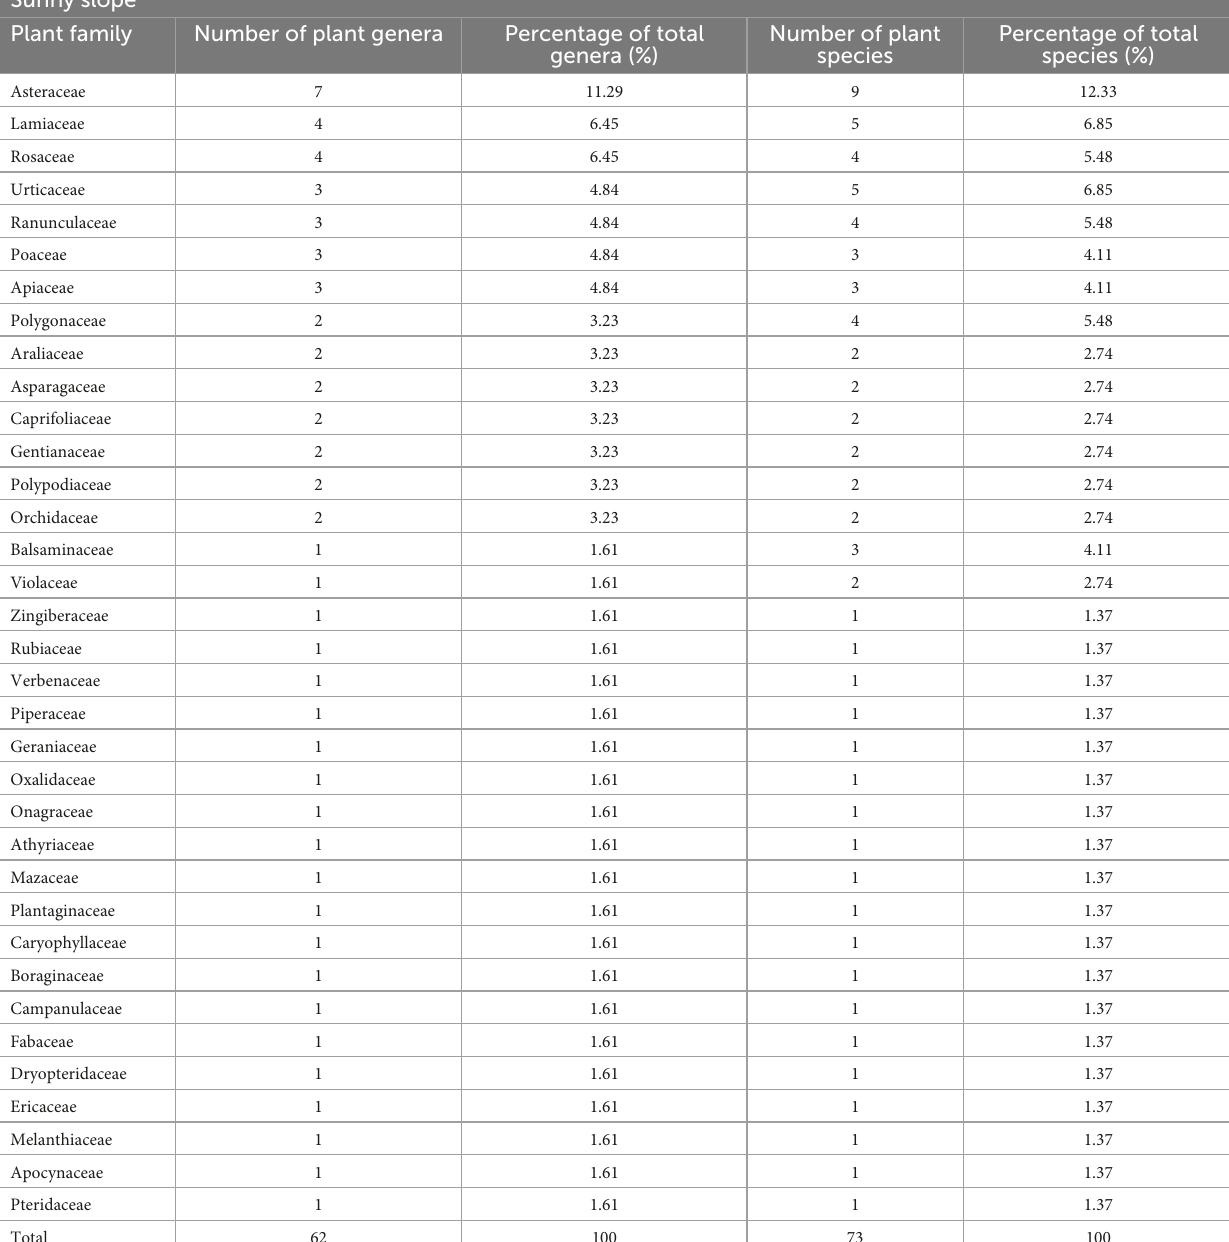
TABLE 3 Composition of herbaceous plants in sunny slope.